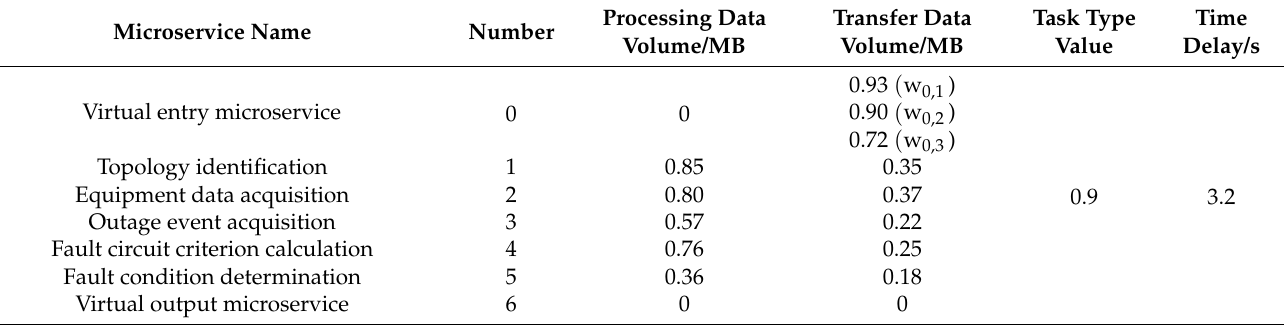
Figure A1. Fault diagnosis task directed acyclic graph. Table A2. Fault diagnosis task